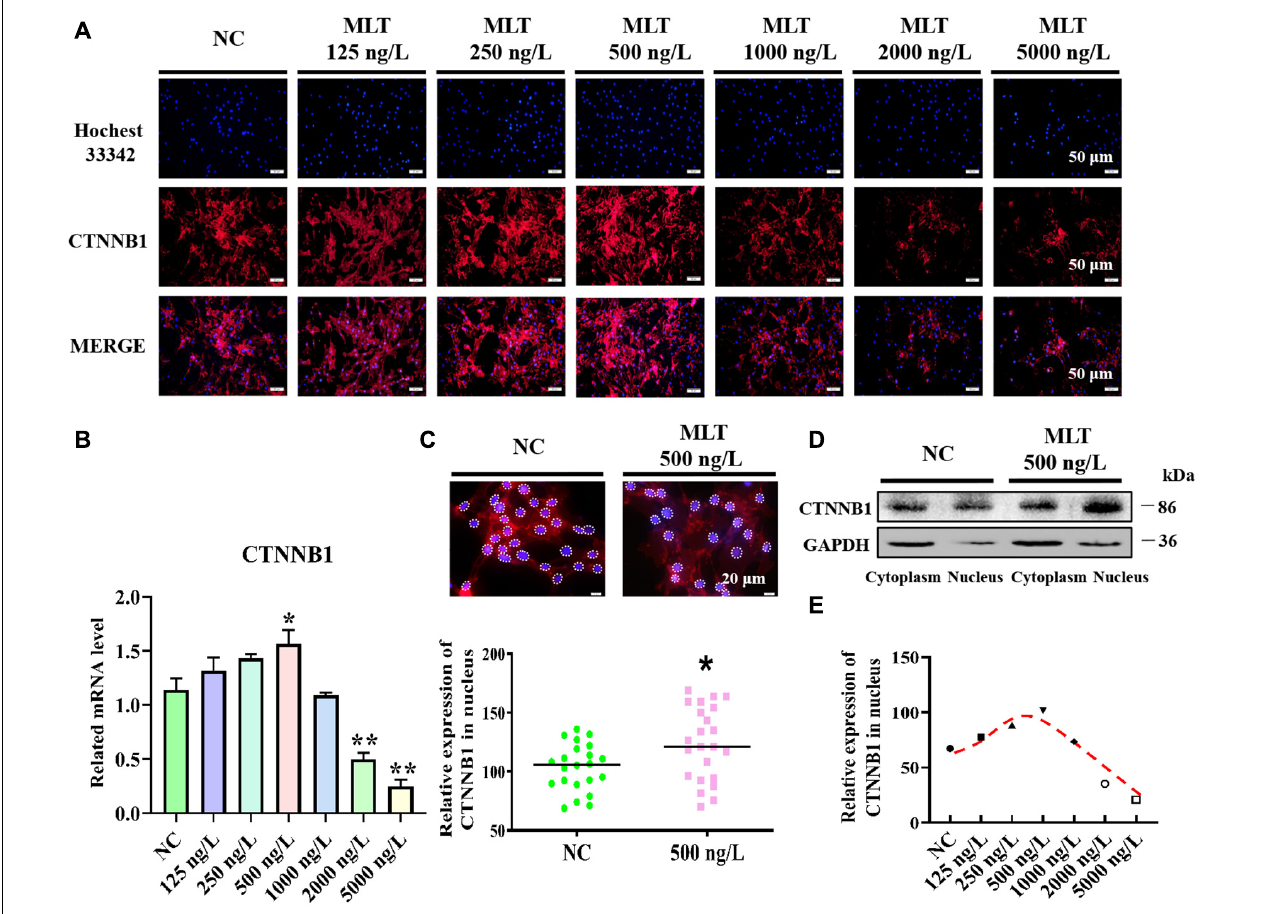
FIGURE 1 | Melatonin activated Wnt signaling pathway in gsHFSCs. (A) CTNNB1 detected by immunofluorescence staining after stimulation with different concentrations of melatonin. Scale bar, 50 µ m. (B) Relative mRNA level of CTNNB1 by RT-qPCR; * p < 0.05, ** p < 0.01. (C) CTNNB1 marked by immunofluorescence in gsHFSCs. Scale bar, 20 µ m (white circles circumscribe the position of CTNNB1 in the nuclei), and relative immunofluorescence intensity of CTNNB1 in the nuclei; * p < 0.05. (D) CTNNB1 in nuclei/cytoplasm as detected by Western blotting. (E) Fluorescence density analysis of CTNNB1 in the nuclei of